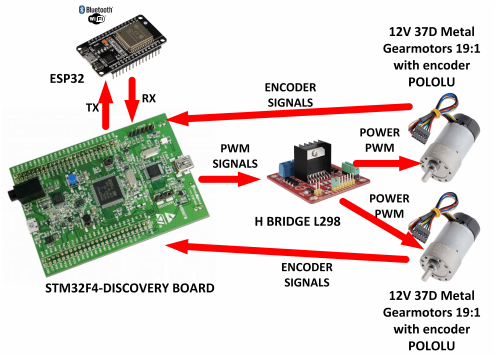
Figure 3. General scheme of the experimental platform (differential-drive